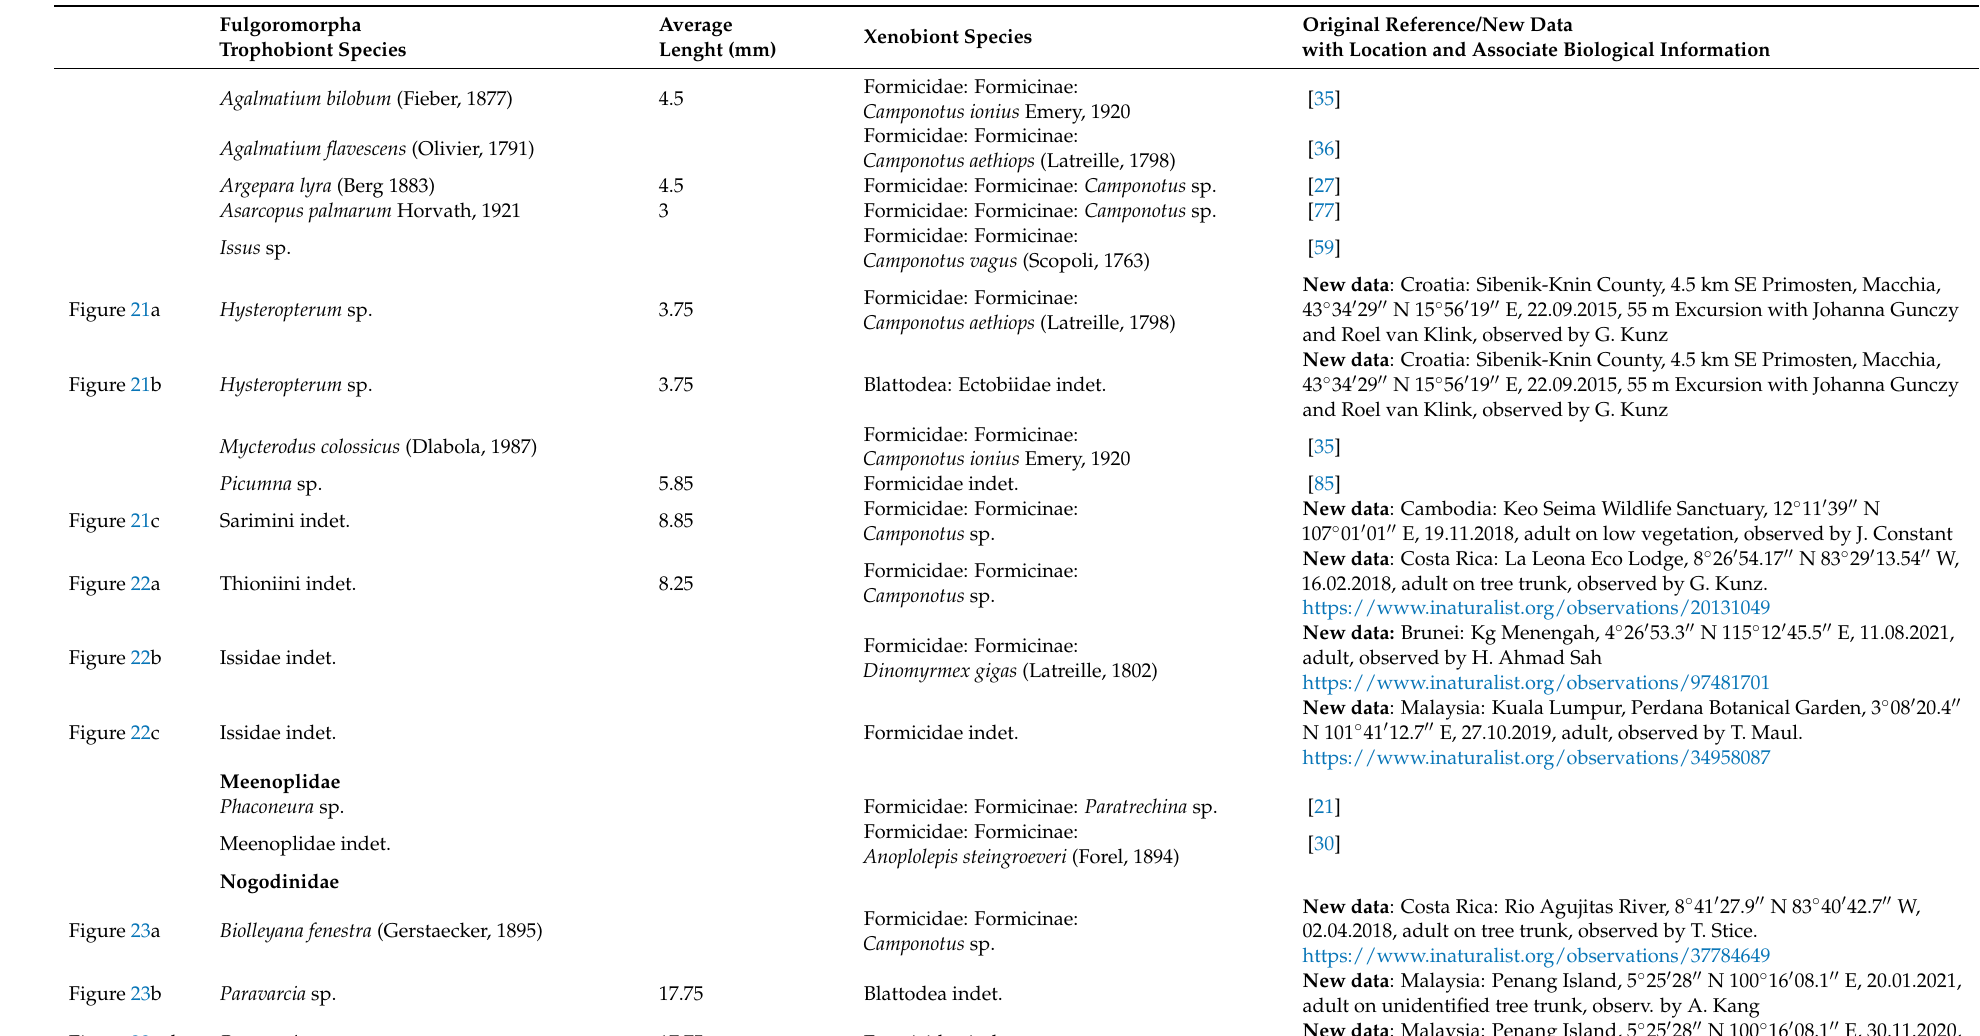
Phaconeura sp. Meenoplidae indet. Nogodinidae Figure 23a Biolleyana fenestra (Gerstaecker, 1895) Figure 23b Paravarcia sp. 17.75 Blattodea indet. Figure 23c,d Paravarcia sp. 17.75 Formicidae